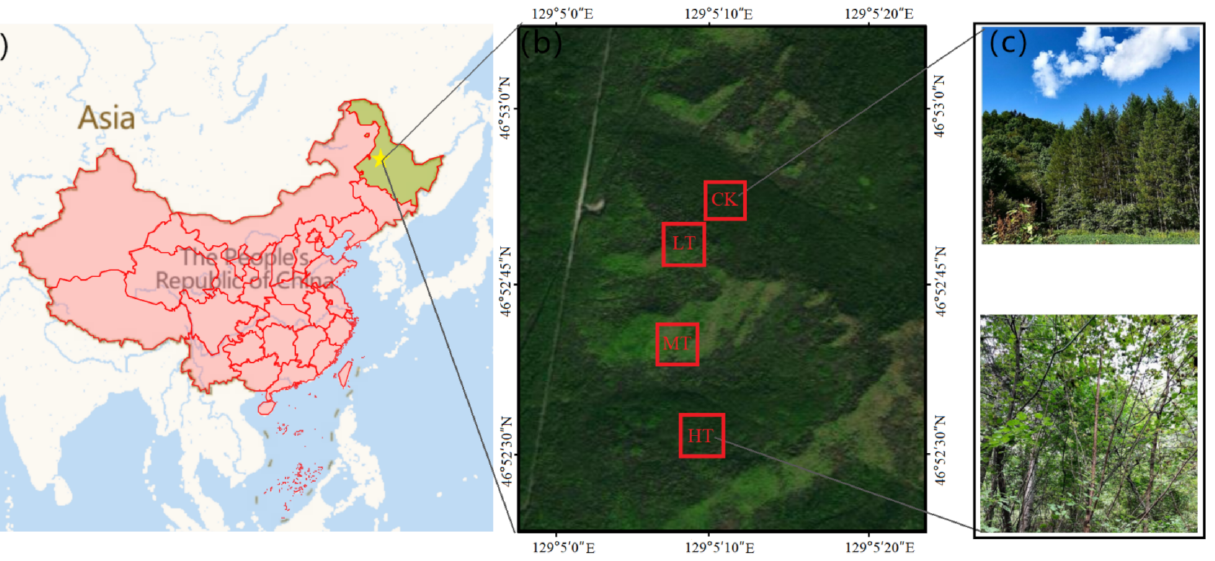
Figure 1. ( a ) The locations of the studied forest stands in the Small Khingan Mountains in China, ( b ) in which 4 stands represent.different thinning treatments, ( c ) contains characteristics of the stands.